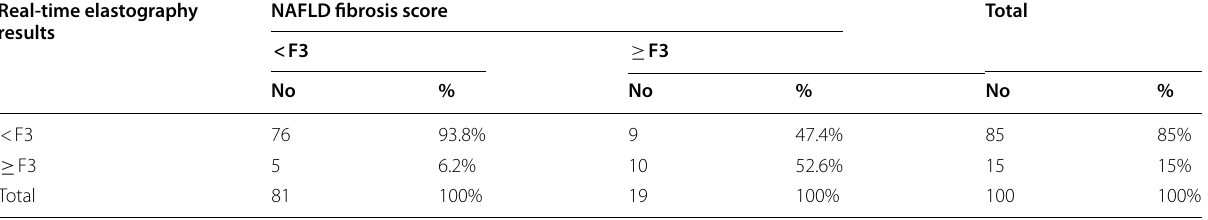
Table 7 Degree of agreement between real-time elastography results and NAFLD fibrosis score results